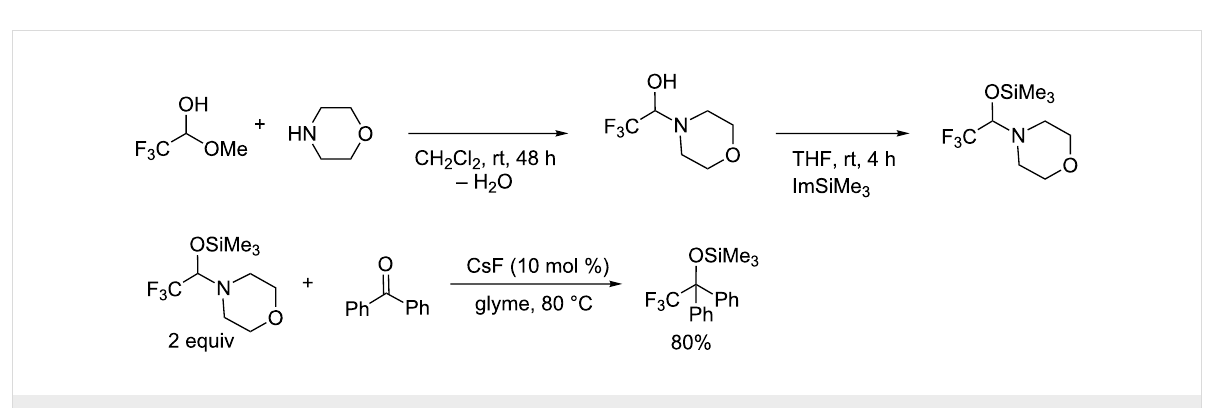
Scheme 14: Trifluoromethylation with silylated hemiaminal of